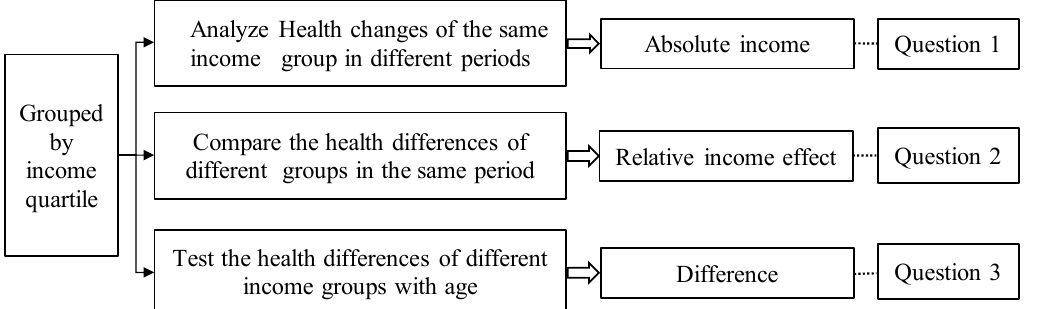
Figure 1. Research framework design.